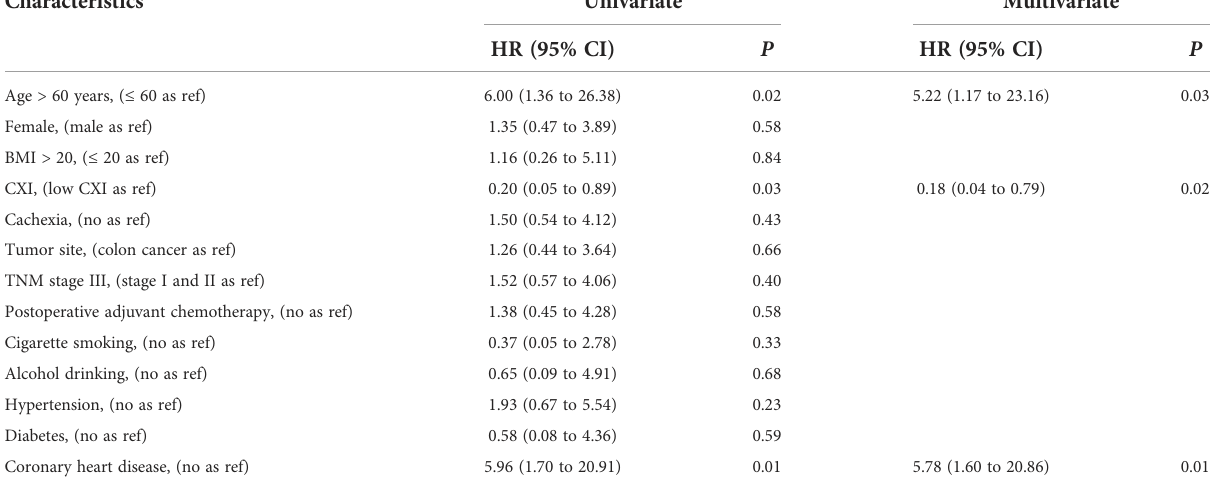
TABLE 3 Univariate and multivariate analysis of overall survival.